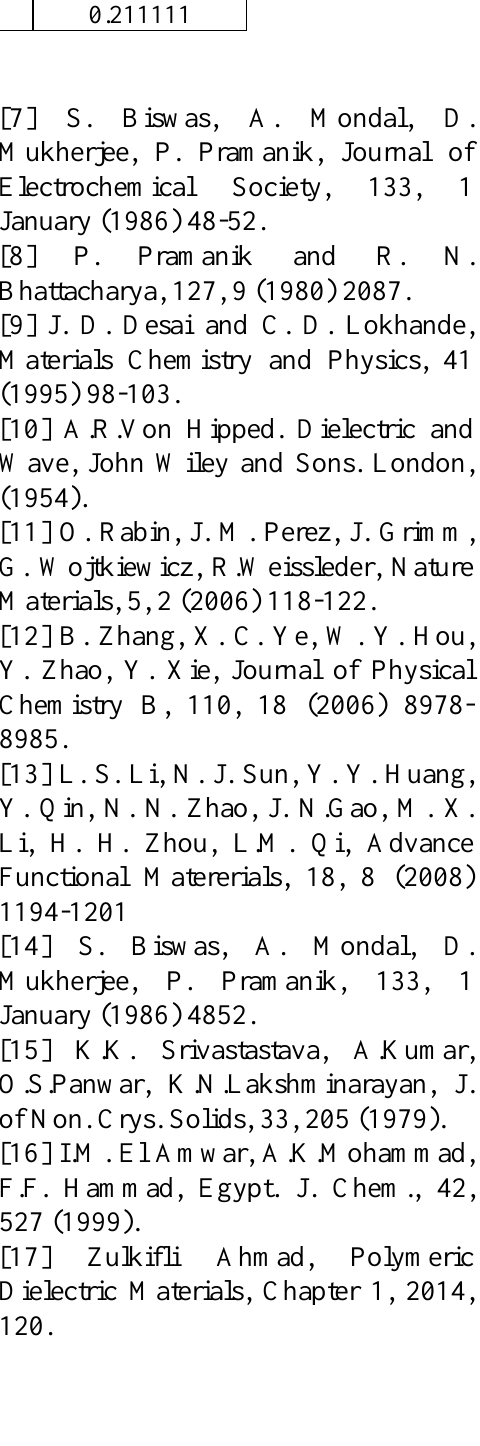
Table 3: The values of α for Bi